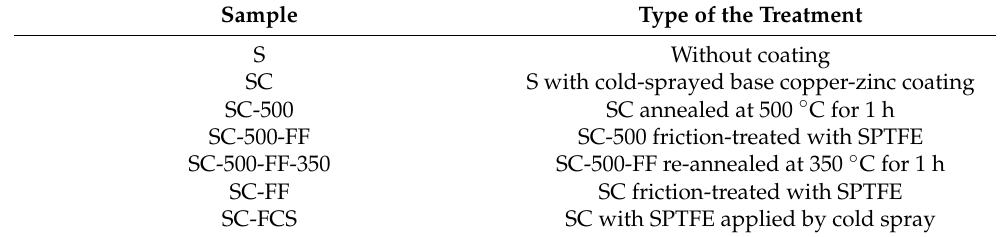
Figure 1. Scheme of sample preparation: CS—cold spray; FM—friction treatment; C-01-11—copper and zinc powder (DIMET ® ); SPTFE—super-dispersed polytetrafluoroethylene (FORUM ® ). Designa- tion of samples is given in the text and Table 2. Table 2. Designation of the sample with different coatings formed on St3 steel.